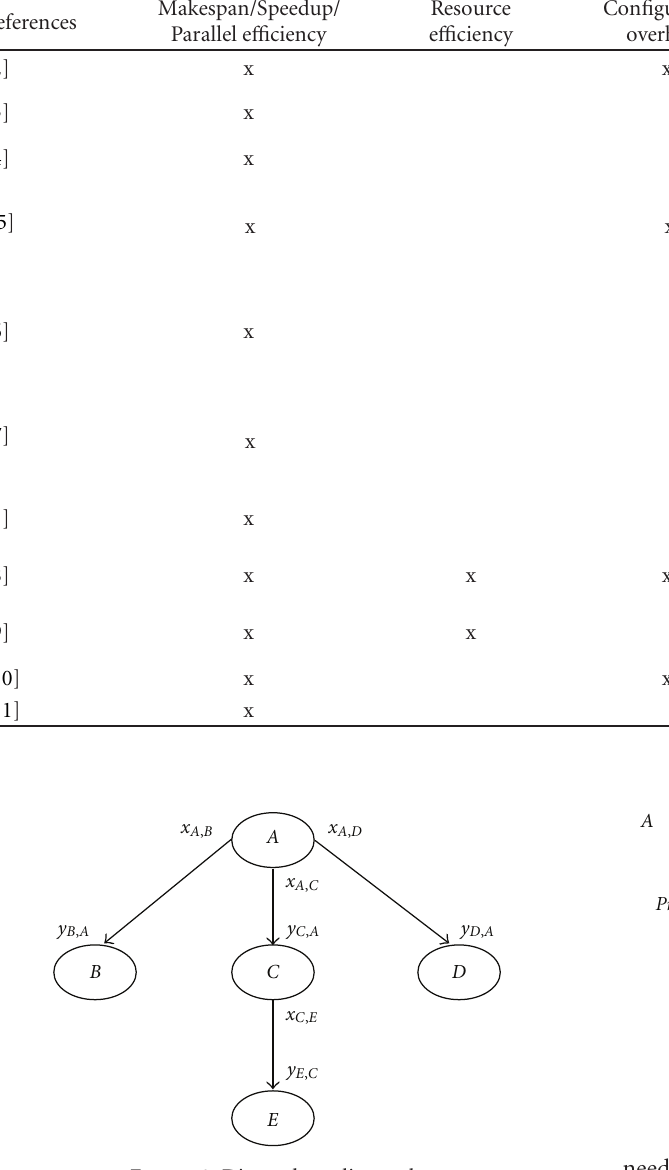
Figure 3: Directed acyclic graph.